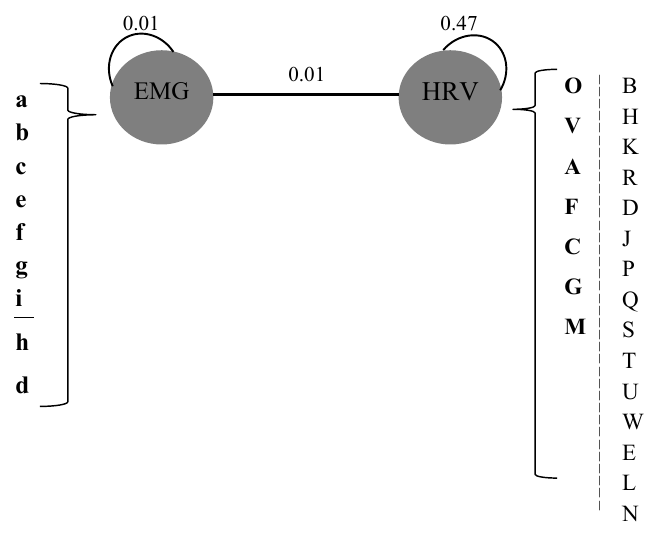
Figure 9. Feature classification using diversity and performance in two